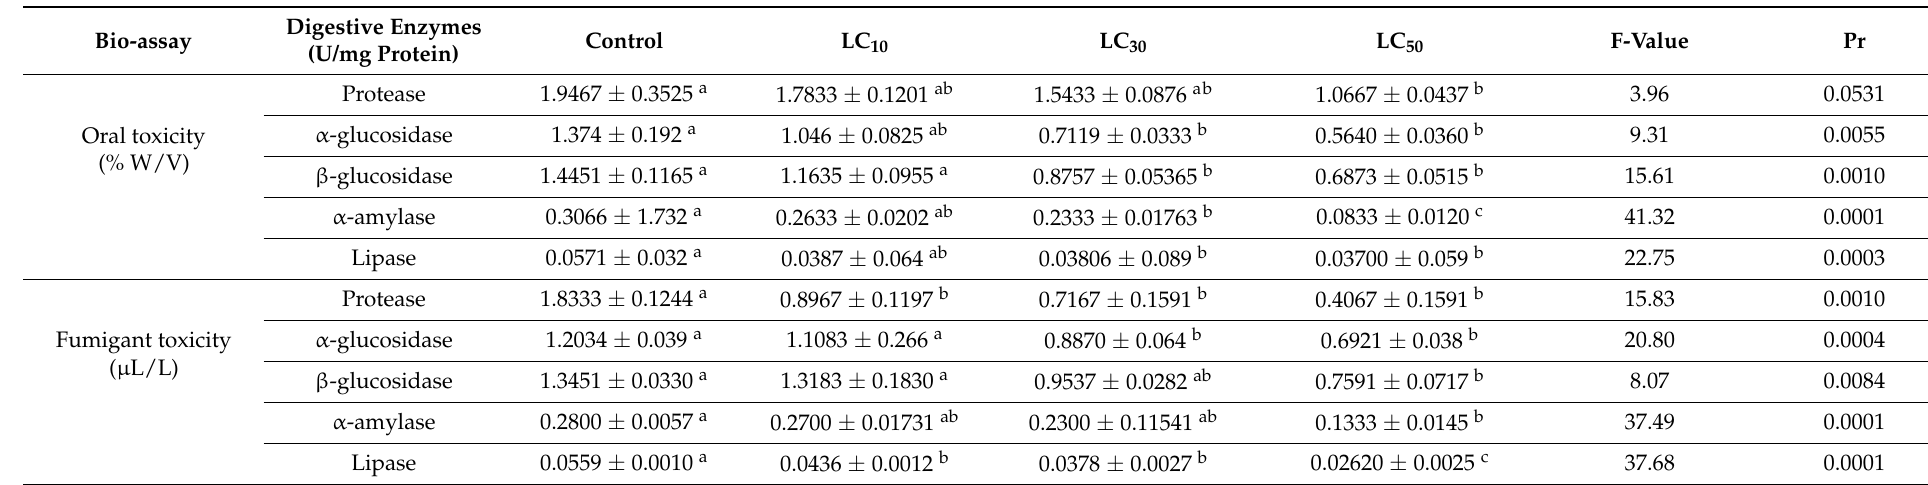
Table 4. Effect of Artemisia annua floral essential oil on digestive enzyme activities in 4th instar larvae of Glyphodes pyloalis